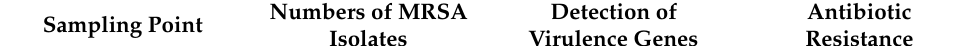
Table 4. The virulence gene identification and antibiotic resistance patterns of every single MRSA isolate. Sampling